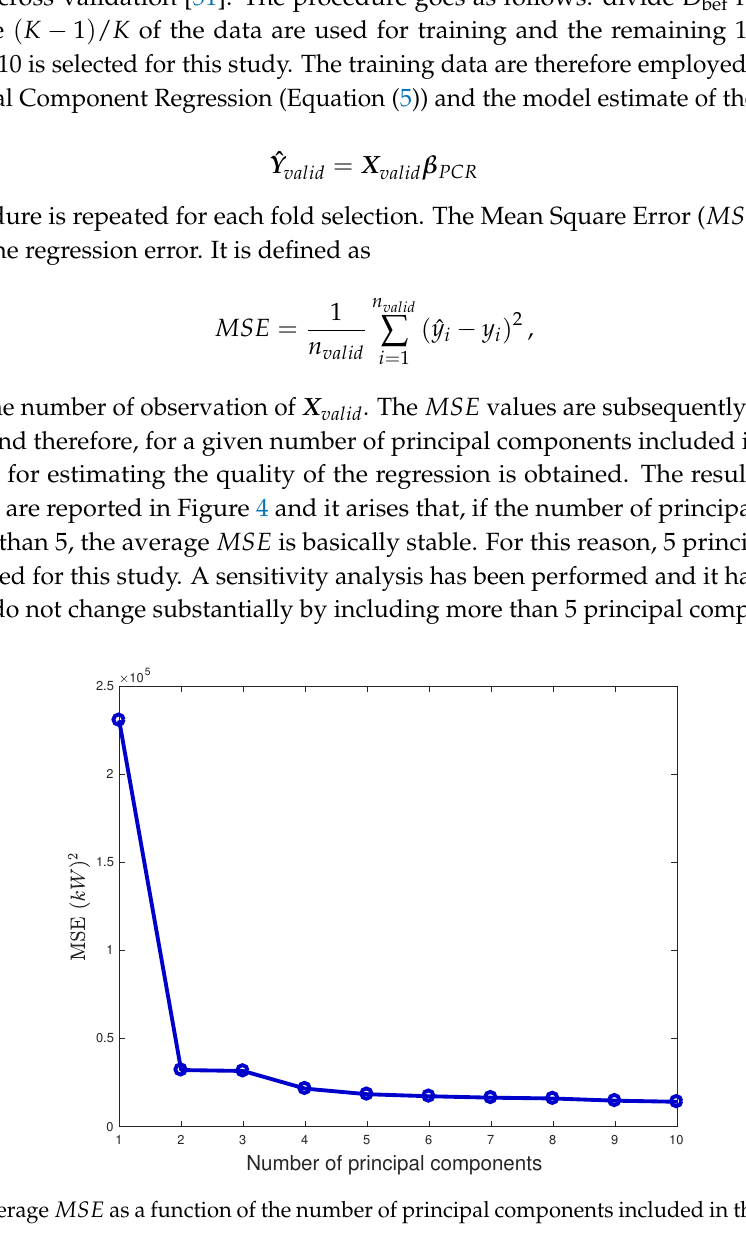
Figure 5. y (power of T1) as a function of the power of T4. D bef data set. Figure 6. y (power of T1) as a function of the first principal component of the covariatives matrix. D bef data set. 4. The results 265